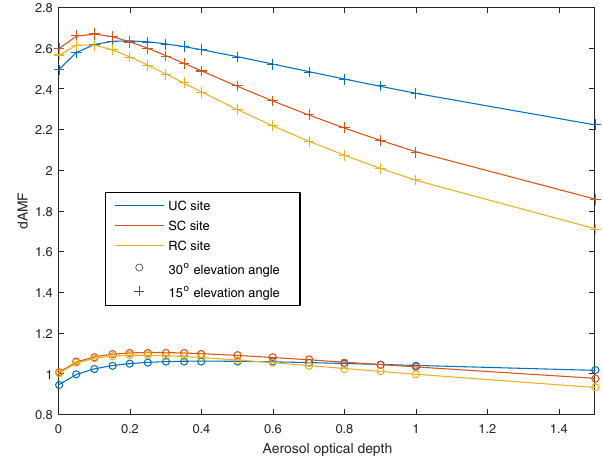
Figure 3. Example of AMFs calculated with libRadtran at SZA 40 ◦ and azimuth angle 80 ◦ relative to the Sun for each campaign site. The AMFs at 15 ◦ (crosses) and 30 ◦ (circles) elevation angles are plotted versus the